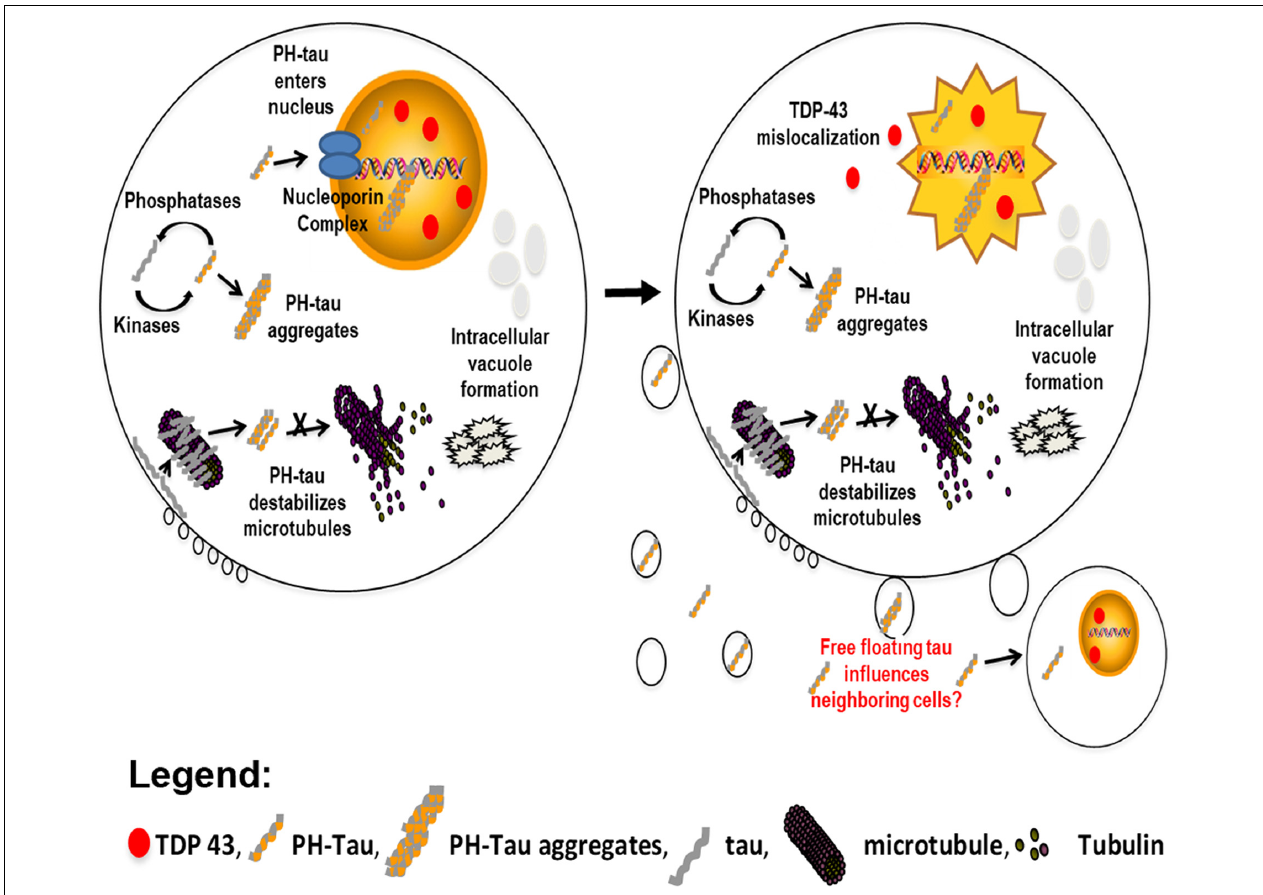
FIGURE 6 | Model proposing the independent actions of pathological tau within a cell. In the cytoplasm, an imbalance of kinase and phosphatase activity contributes to the hyperphosphorylation of tau. This hyperphosphorylated tau can sequester normal tau to form aggregates. This behavior results in destabilization of the microtubule network and the formation of intracellular vacuoles (left). We have now demonstrated that PH-tau is able to translocate into the nucleus (left & right). This results in disruption of the nuclear lamina and mislocalization of the nuclear protein TDP-43 (red ovals) to the cytoplasm, ultimately inducing cellular death (right). It is currently hypothesized that PH-tau can propagate in a prion-like manner. We have shown that monomeric tau can be uptaken by healthy neurons (Morozova et al., 2019), and other reports have seen the same for oligomeric tau (Guo and Lee, 2013; Calafate et al., 2015; Evans et al., 2018). This uptake of PH-tau by healthy cells could spread the cytoskeletal and nuclear